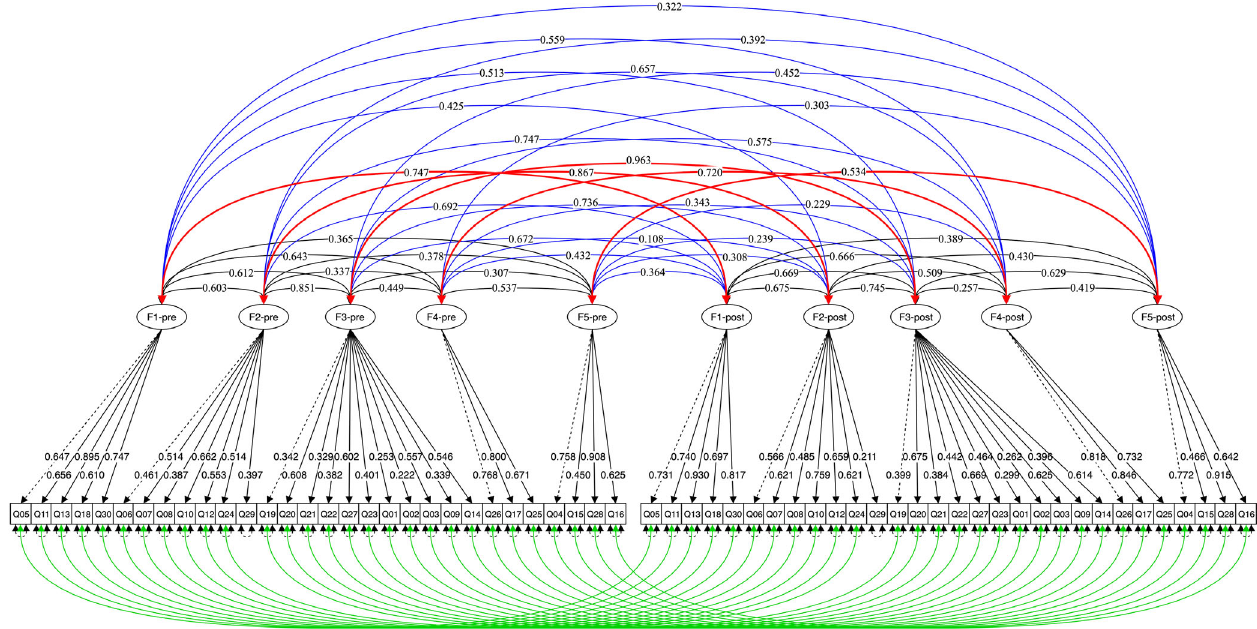
FIG. 1. Partial strict LMI model of the FCI (Freely estimated variance for item 29 at the post-test time). The modified SSG5M model suggested the following five factors: F 1 ¼ Identification of Forces, F 2 ¼ 1 st Law with 0 Force, F 3 ¼ 2 nd Law with Kinematics, F 4 ¼ Superposition, and F 5 ¼ 3 rd law. Because of the data ’ s longitudinal structure, the latent factors are allowed to correlate across time (the correlation between identical latent factors in the different time was in red curves; the correlation between different latent factors in the different time was in blue curves), and identical items over the two test occasions were allowed to covary except for item 29 (green curves). All parameters are standardized.